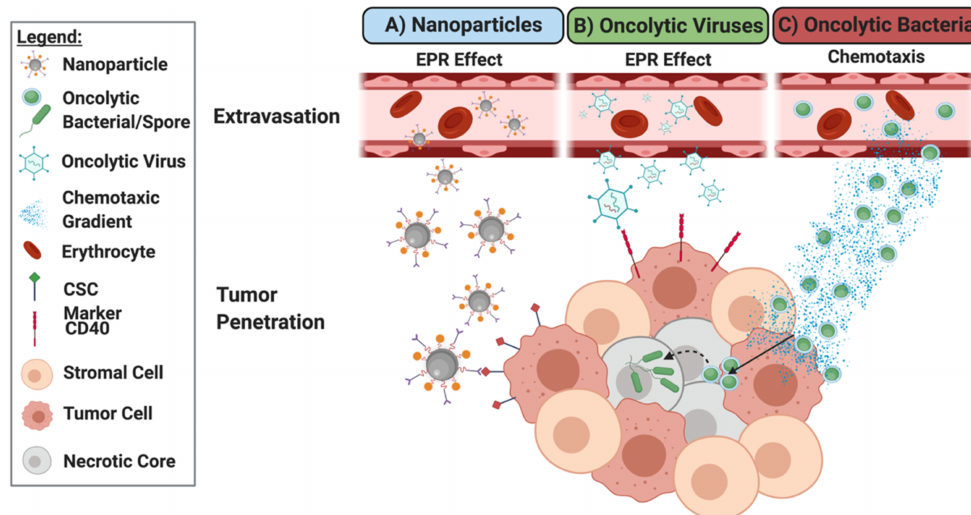
Figure 3. Summary of tumor localization mechanisms. ( A ) Nanoparticles use the Enhanced Perme- ability and Retention Effect (EPR) allowing molecules of less than 300 nm diameter to accumulate in tumor tissues due to abnormal tumor vasculature [17]. This figure depicts a generic nanoparticle targeting to a Cancer Stem Cell Marker (CSC) for entry and payload delivery; ( B ) Viruses also use the EPR effect in conjunction with upregulated cell surface markers for enhanced targeting specificity [68,69]. After entry the DNA or RNA payloads are delivered to the cell [70]; ( C ) Bacteria can follow chemokines to the site of the tumor before migrating to the hypoxic core to undergo sustained replication